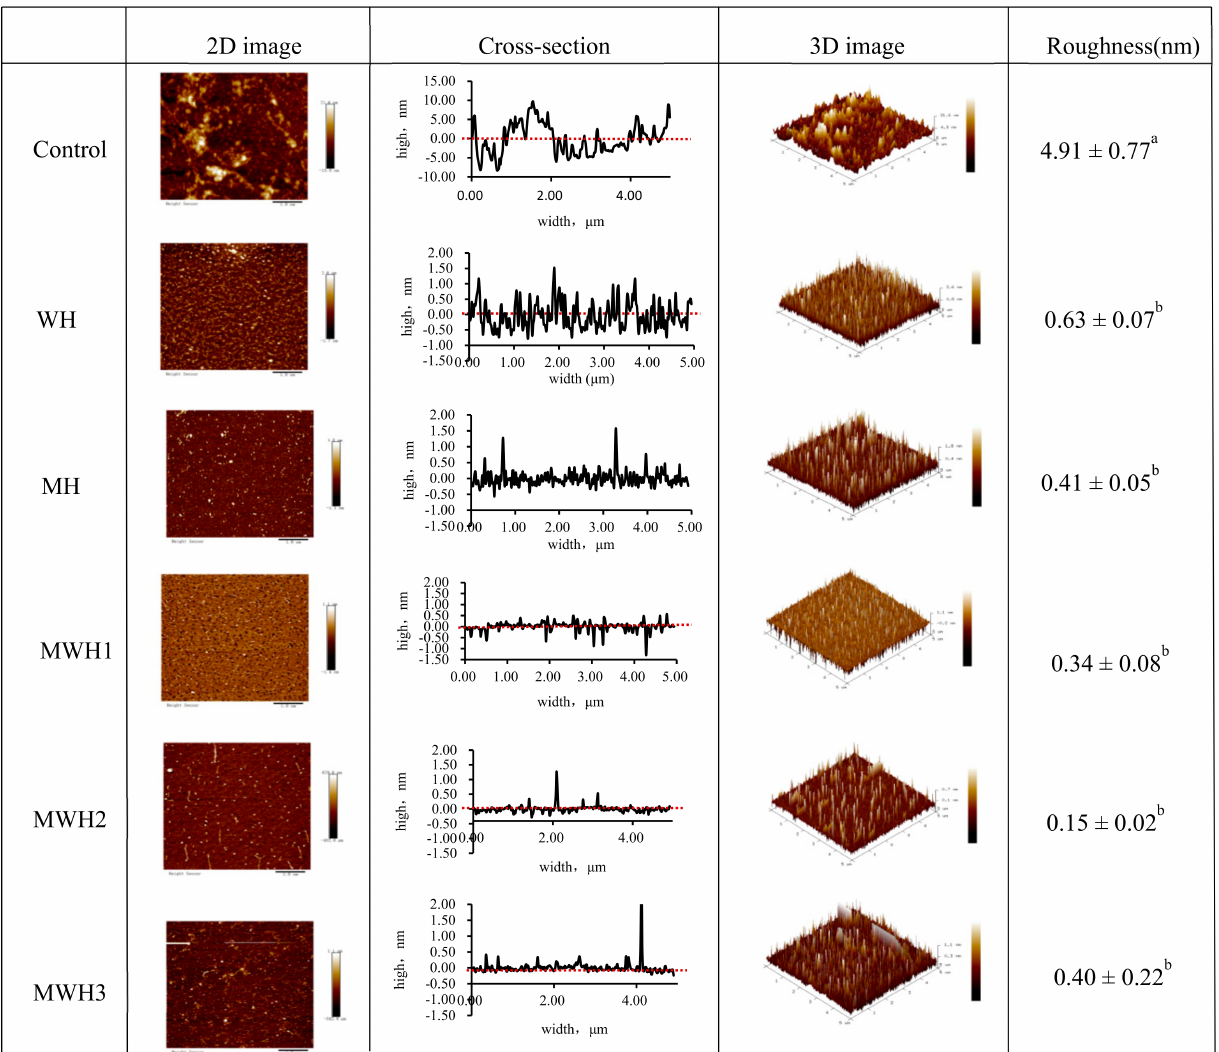
Figure 7. 2D and 3D images of AFM with different heating methods of SCM and the cross-section reflected the largest roughness on the 2D images. Different lowercase letters indicate significant differences in mean roughness values between SCM in different heating modes ( p <